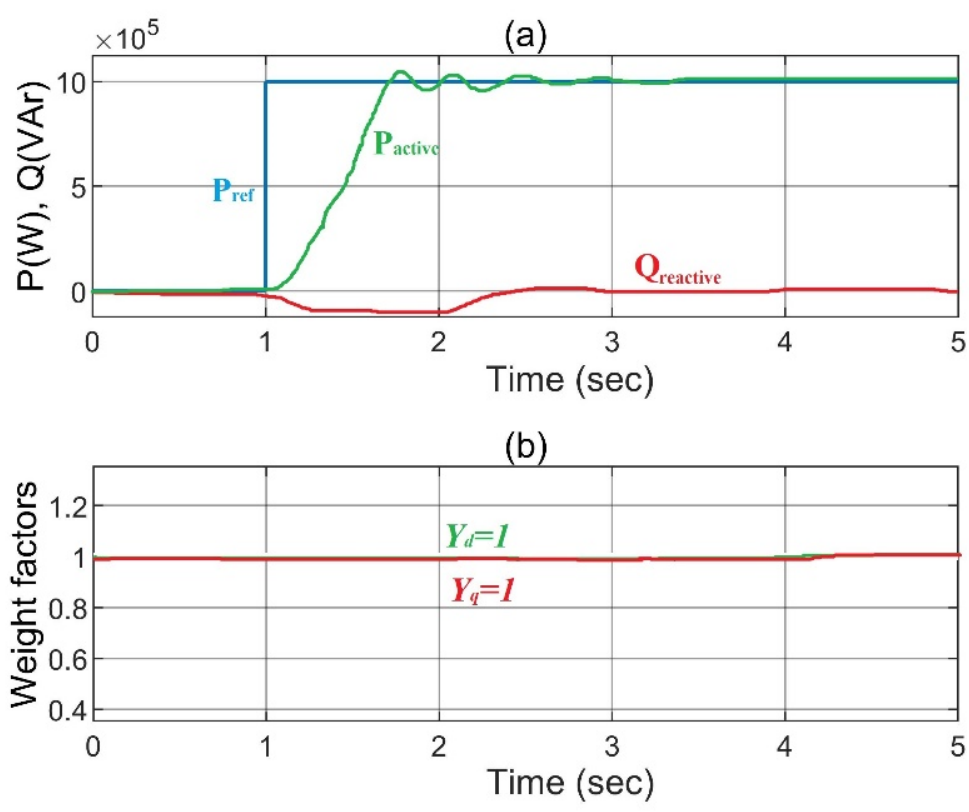
Figure 8. Step-response of FCS-MPC during fixed WFs. ( a ) Active power and Reactive power ( b ) Dynamics of WFs.